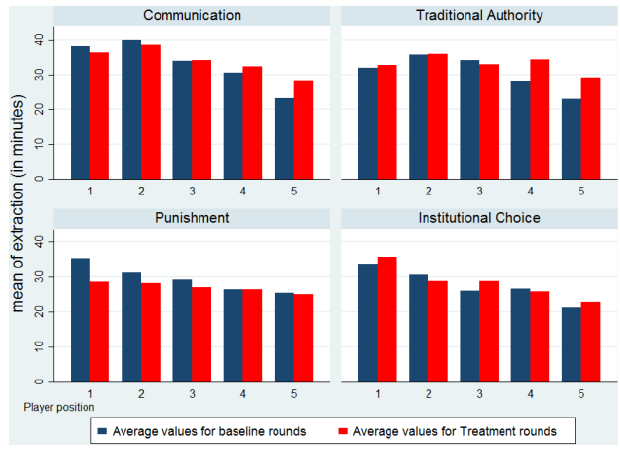
Fig. 9. Average earnings depending on player position for different sanction